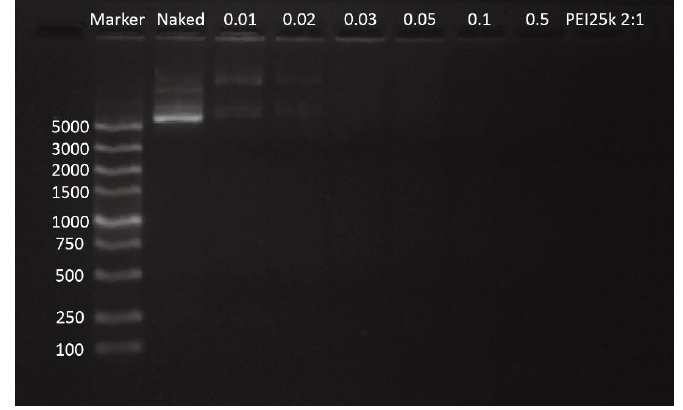
Figure 2. Agarose gel electrophoresis of the GPEI-pDNA polyplexes.